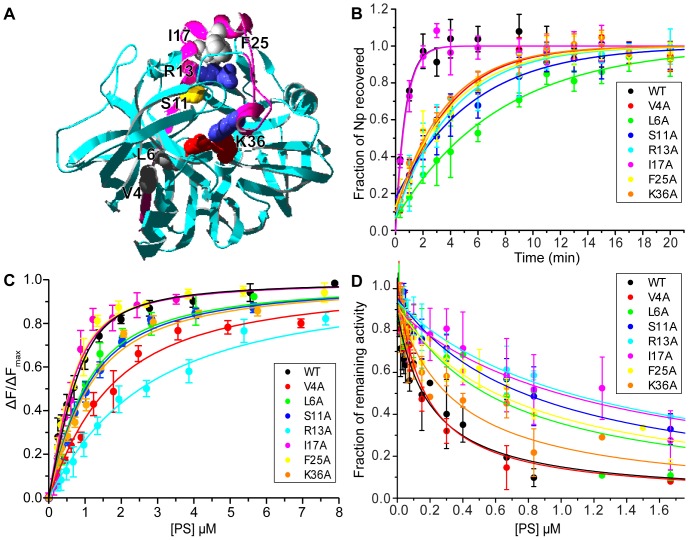
Effects of PS point mutants on binding and catalyzing pepsin folding.(A) Structure of pepsinogen (PDB code: 3PSG) with the PS (pink) located between the N- and C-terminal lobes, forming part of a six-stranded β-sheet, and K36 of the PS interacts with the catalytic residues, D32 and D215 (red). PS residues selected for mutation to Ala are shown in space-filling form and coloured according to type (grey-hydrophobic, orange-polar, blue-basic, red-acidic). (B) Comparison of wild-type and mutant PS-catalyzed folding of pepsin. The rate of PS-catalyzed folding (k
f) was determined by adding PS to Rp, at pH 5.3, 15°C (see Text S2: folding rate followed Arrhenius temp-dependence from 0—15°C, shown in Fig S5), and measuring the formation of Np based on enzyme activity measured at pH 1.2, 25°C. The data were fit according to a monoexponential function to obtain k
f. (C) Comparison of wild-type and mutant PS affinity for Rp. PS-Rp binding was determined by following the increase in Trp-fluorescence of pepsin as a function of [PS]. The data were fit according to eq 1 to determine the dissociation constant, K
d, at 20°C, pH 5.3. (d) Comparison of wild-type and mutant PS affinity for Np. The reduction in Np activity was measured as a function of [PS]. The data were fit according to a competitive inhibitor model, eq 2, to determine the inhibition (dissociation) constant, K
i, at 20°C, pH 5.3. All data are reported as the average ± SD of 3-5 measurements for each PS peptide.